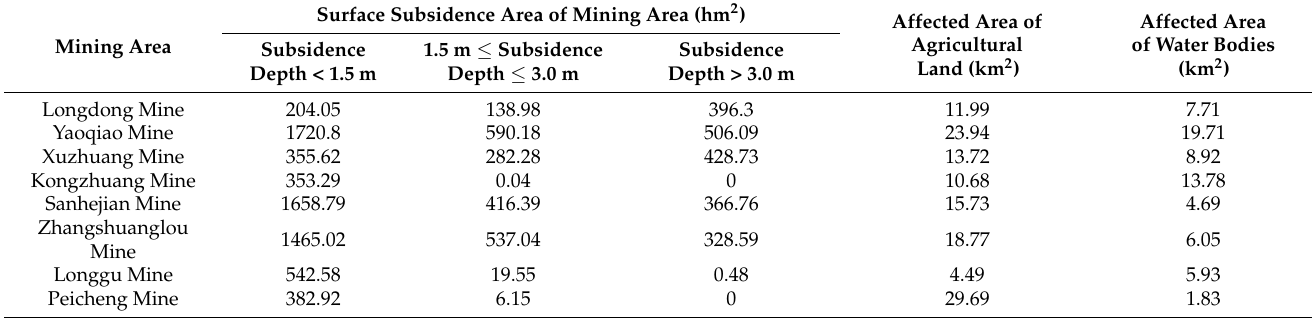
Table 1. Status of mining area in Peixian.